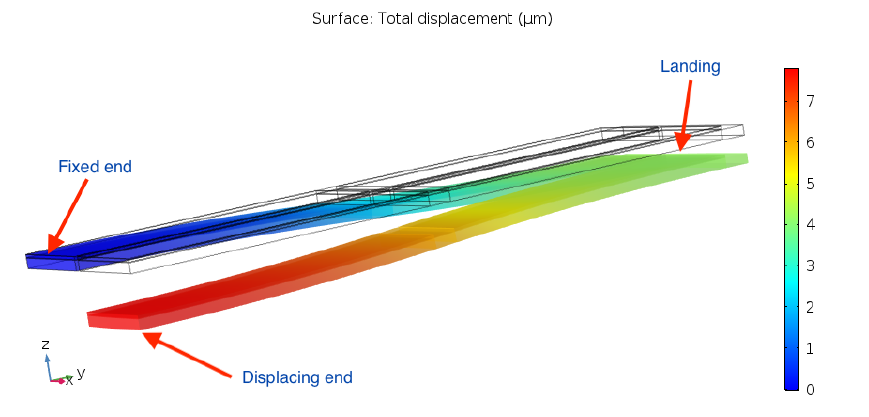
Figure 11. 2nd-order staircase actuator’s flexural displacement, where comparison to Fig. 6 shows that the cantilever yields zero net start-to-endpoint displacement and the staircase doubles its start- to-endpoint displacement compared to a 1st-order device.